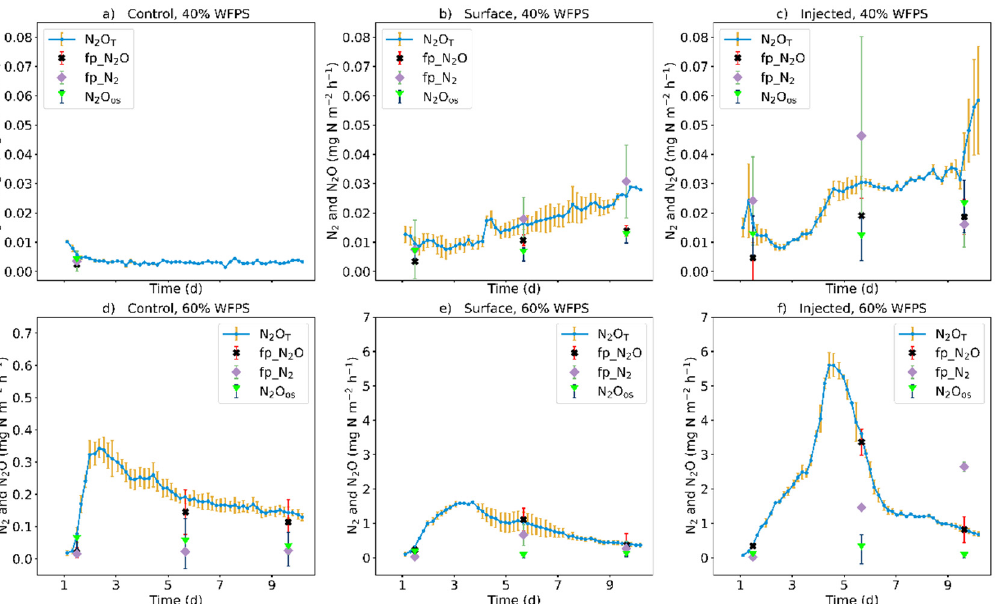
Figure 2. Measured total N 2 O flux (N 2 O T ; blue line, continuous GC measurement), fp_N 2 (purple dots; 15 N-sampling), fp_N 2 O (black dots; 15 N-sampling) and N 2 O os (green dots; N 2 O T -fp_N 2 O) during a laboratory incubation of a sandy, arable soil from Fuhrberg, Germany. The water content (40% ( a – c ) and 60% ( d – f ) WPFS) was kept constant during the experiment. Three manure treatments were applied: control (no manure) ( a , c ), surface-applied manure (manure on the surface) ( b , d ) and injected manure (manure in the middle layer of the soil) ( c , f ). The yellow lines represented the standard deviation of the three parallel measurements. The first visualised measurement was taken within 18 h of the soil columns being packed.